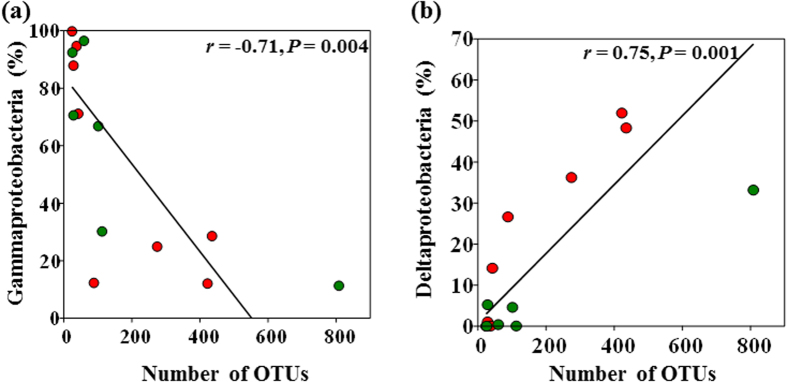
Linear regressions were used to test Pearson’s correlation between number of OTUs detected for Gamma- and Deltaproteobacteria in high and low MeHg DWW samples.(a) The correlations between number of OTUs and relative abundance of Gammaproteobacteria. (b) OTUs and relative abundance of Deltaproteobacteria in DWW. Pearson correlation coefficient and P values are shown. Red and green dots represent high and low MeHg samples, respectively.